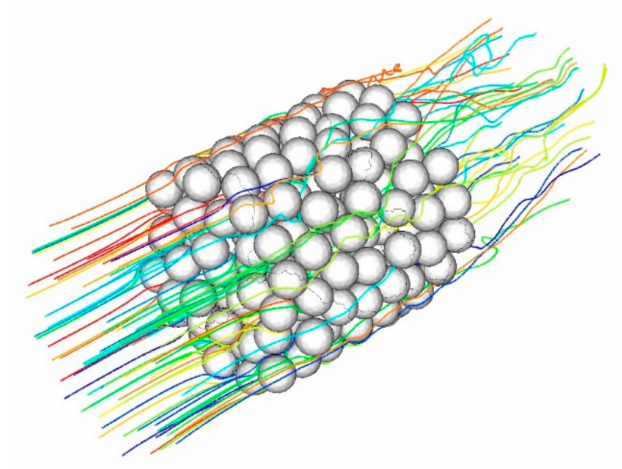
Figure 4. Particle trajectories in the filter model.